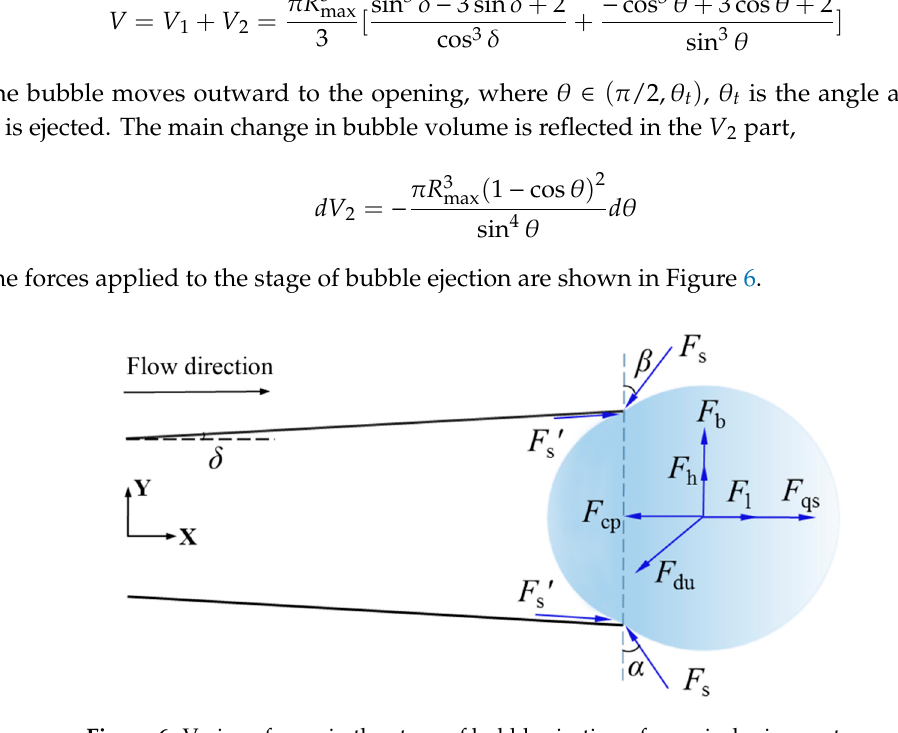
Figure 6. Various forces in the stage of bubble ejection of a conical micromotor. The surface